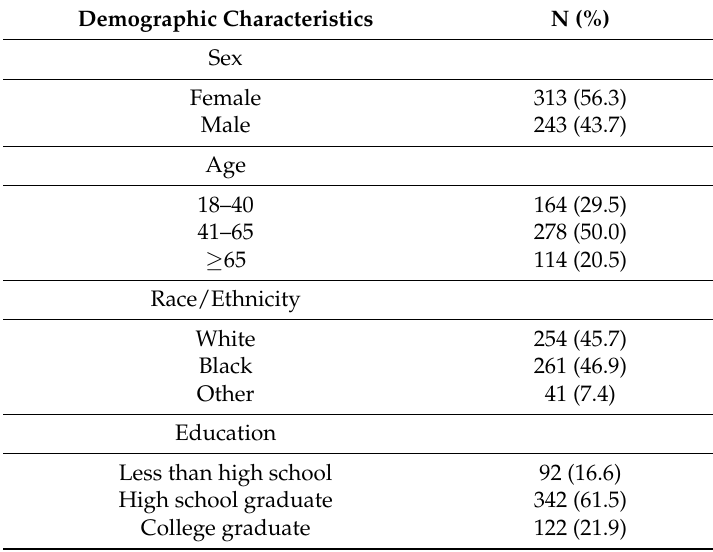
Table 1. Demographic characteristics of the study sample, N =